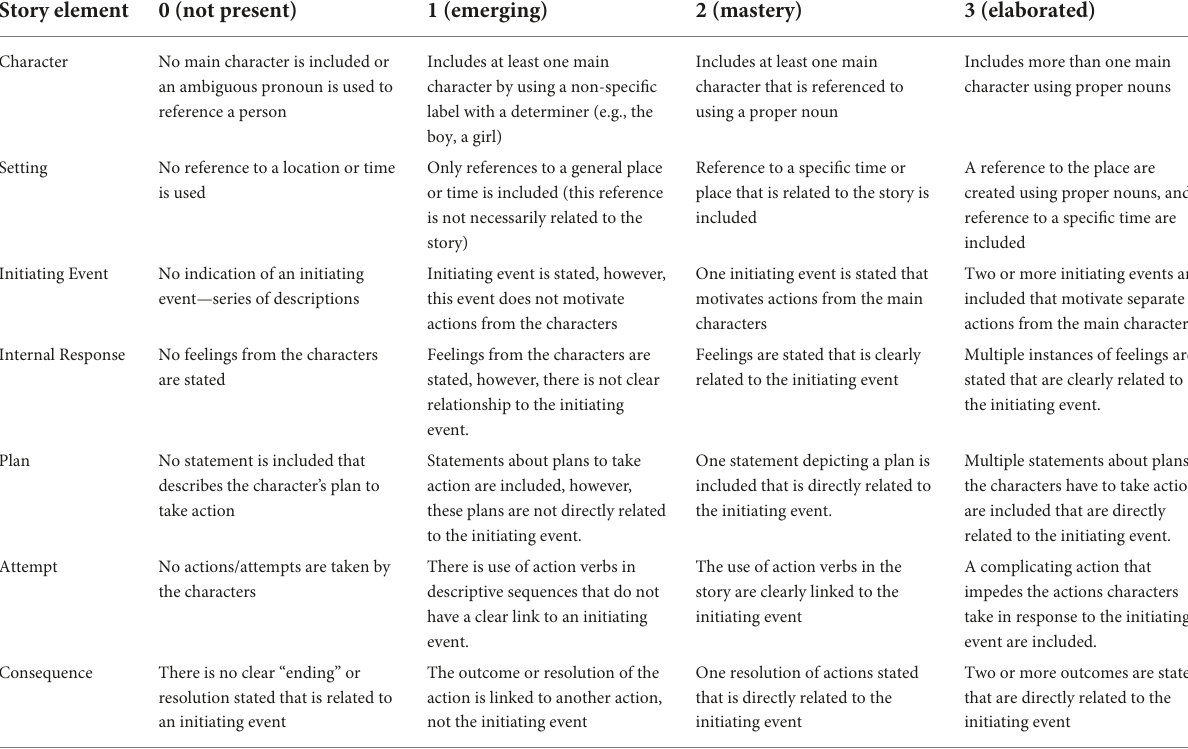
TABLE 1 Macrostructure subscale story elements and scoring